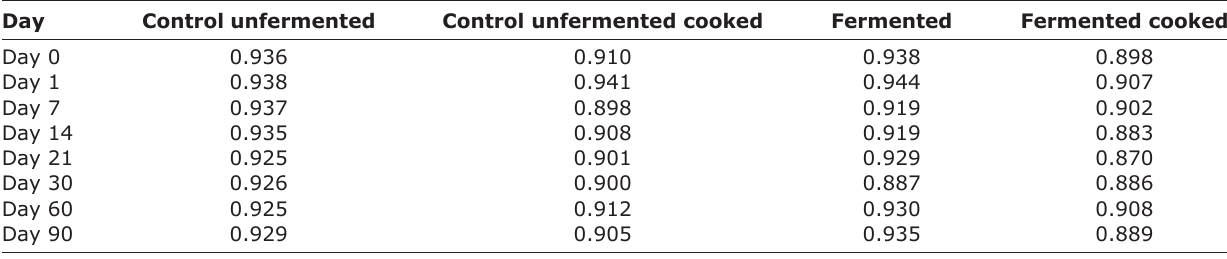
*Significant difference between day 0 and sampling day within a treatment group (p<0.05) Table-2: Average water activity of fermented and unfermented pork sausage with and without cooking. Day Control unfermented Control unfermented